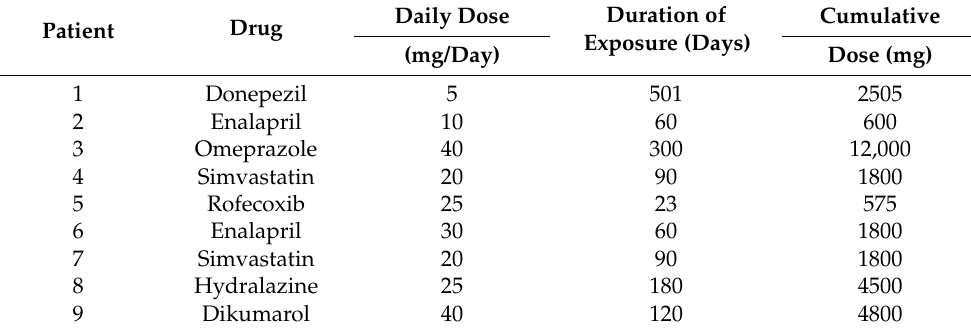
Table 5. Role of cumulative doses of drugs implicated in causing iDILI. Results were calculated from data presented in an earlier study [23]. Data were derived from patients, who used the drugs at a dose of <50 mg daily as documented in the Swedish Hepatic ADR Dataset and experienced a poor outcome of iDILI like death or liver transplantation. Abbreviation: ADR, Adverse Drug Reaction.